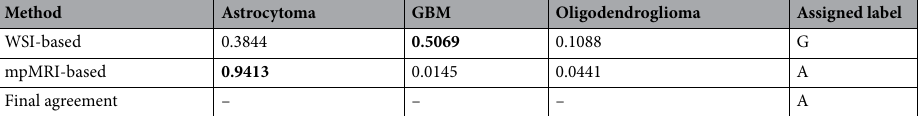
Table 3. Voting distribution and predicting probabilities by using WSI-based and mpMRI-based methods, respectively. The maximum probability is in bold.